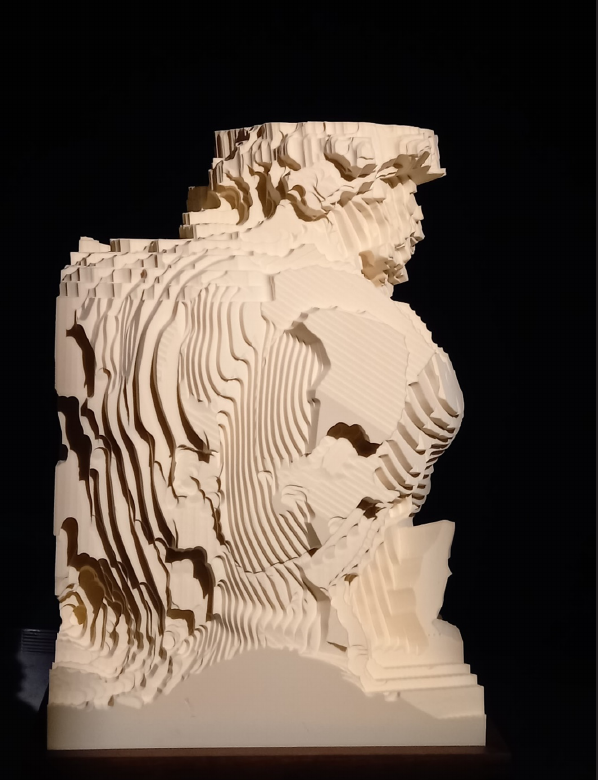
Figure 6: Davide Quayola. Pluto #F_03_S4, 2020. Photo Susan Broadhurst, 29 th September,